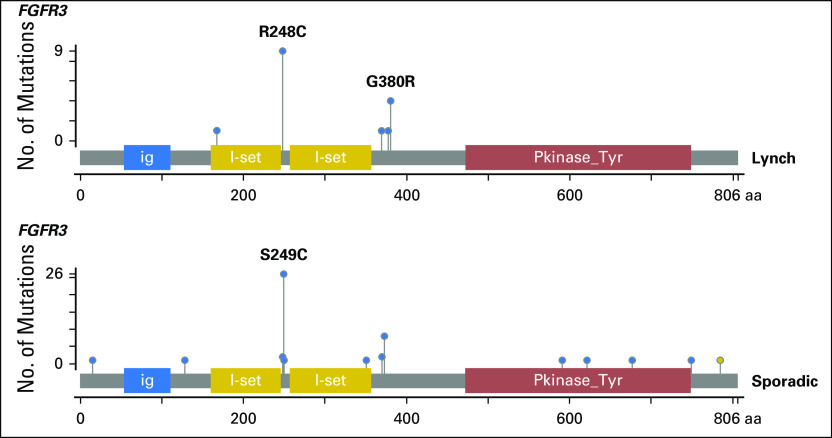
Lollipop plots of FGFR3 mutations in the sporadic and Lynch cohorts.